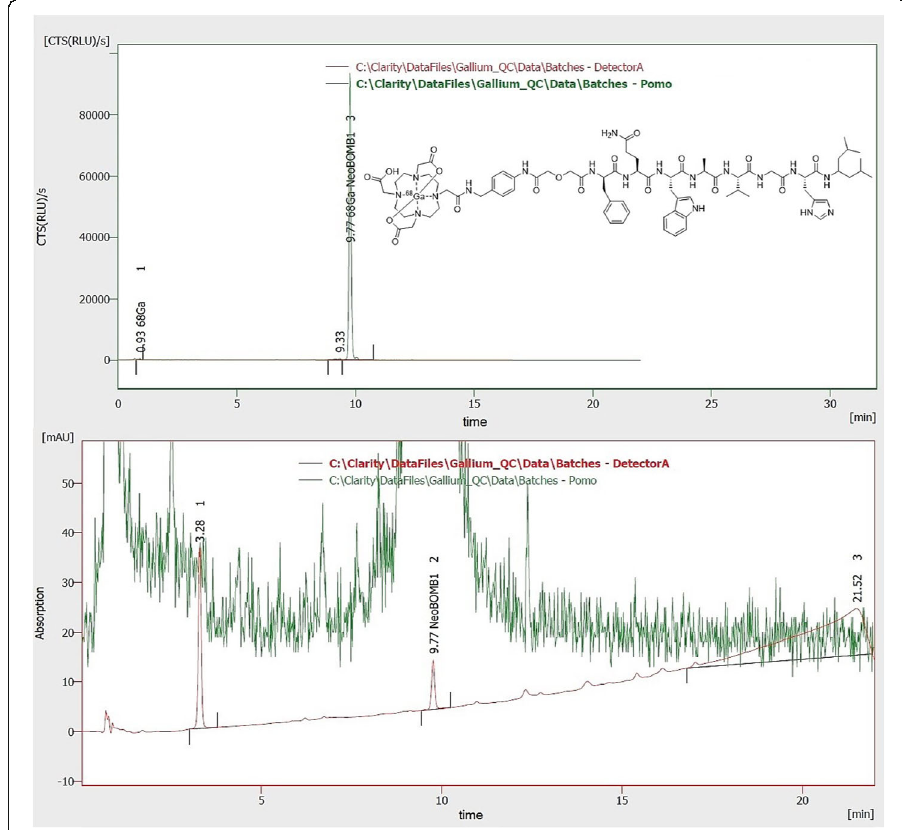
Fig. 1 Representative (radio-)chromatogram of [ 68 Ga]Ga-NeoB quality control. Green represents the activity signal and red the UV signal. The chemical structure of [ 68 Ga]Ga-NeoB is in the upper chromatogram. The lower chromatogram shows a zoom of the upper chromatogram for determination of non-radioactive